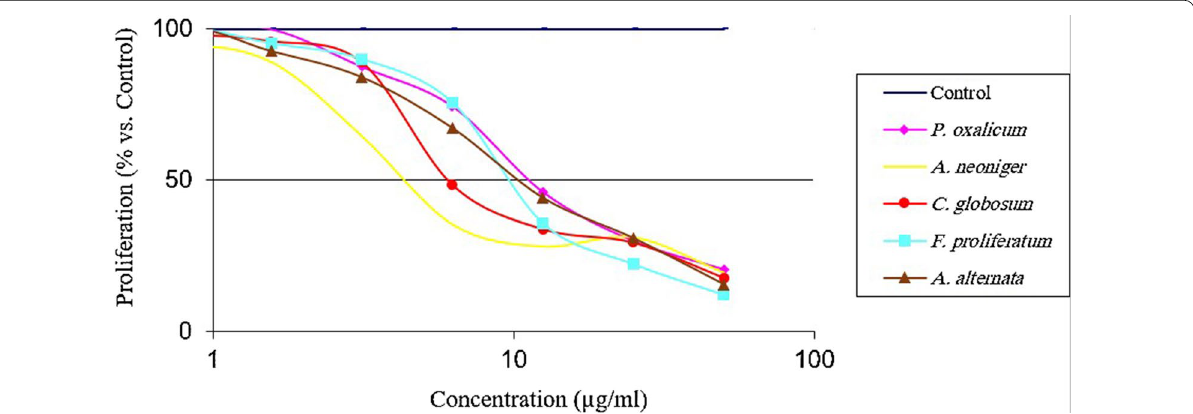
Fig. 2 Antiproliferative effect on